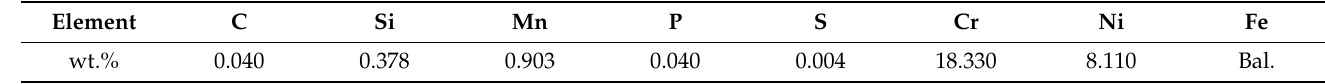
Table 1. Chemical composition of 304 stainless steel.